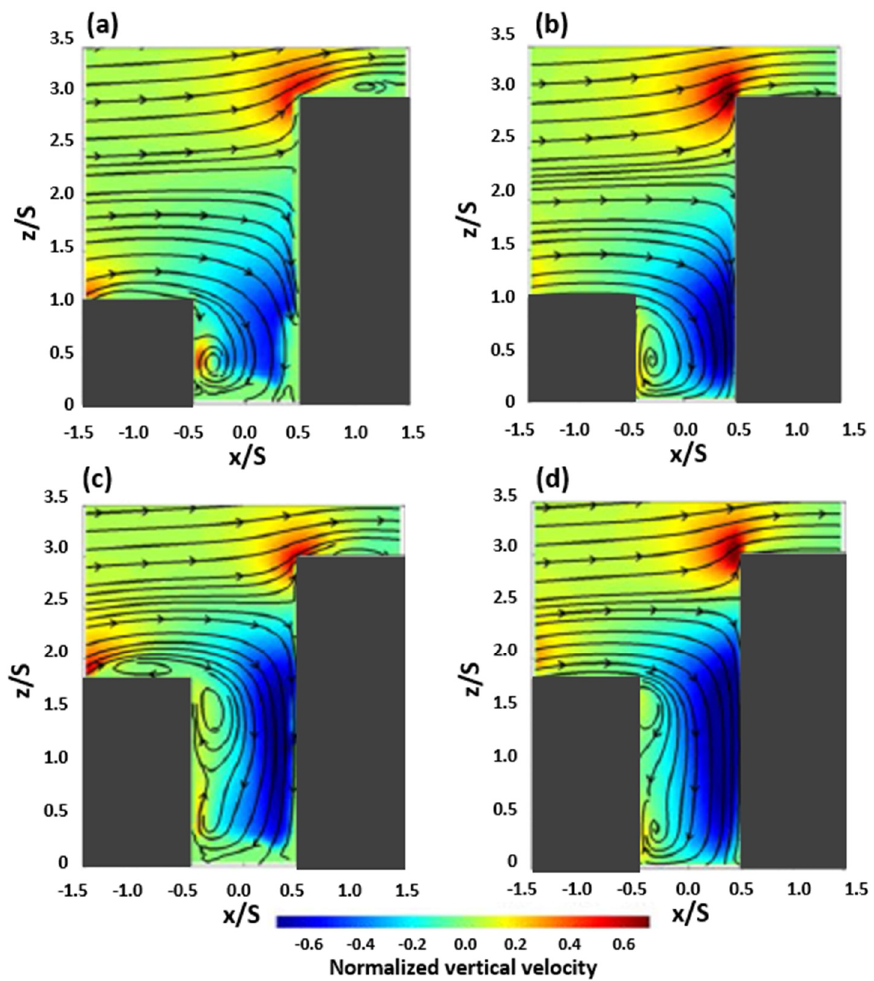
Figure 1. Streamlines and contours of the normalized vertical wind component measured by Addepalli and Pardyjak (2013) [24] ( a , c ) and simulated by Park and Kim et al. (2020) [25] ( b , d ) in shallow canyons (upper panel) and deep canyons (lower panel).